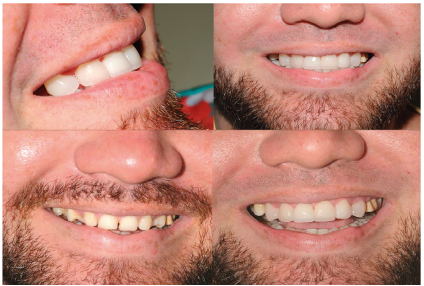
Figure 16: Final